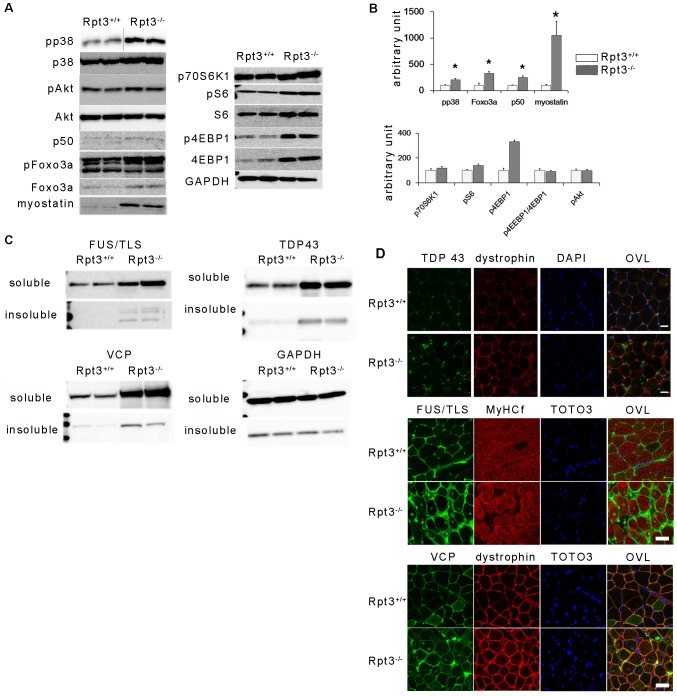
Catabolic pathways in the gastrocnemius muscles of Rpt3−/− mice. (A) Immunoblotting analysis for the detection of muscle atrophy-related signaling pathway components. (B) Quantification of the data from A. The amount of phosphorylated p38 (pp38) was also increased in Rpt3−/− mice. No apparent differences were observed in the levels of Akt and phosphorylated (p)Akt. Foxo3a, p50, and myostatin were increased. Phosphorylated (p)Foxo3a, p70S6K1, phosphorylated (p)S6, S6, phosphorylated (p)4EBP1, 4EBP1 and GAPDH were also present. The ratios of phosphorylated S6∶S6 and phosphorylated 4EBP1∶4EBP1 were not altered, whereas the total amount of phosphorylated 4EBP1 was increased. Data show the mean+s.e.m.; *P<0.05 (Student's t-test). (C) Proteins related to RNA metabolism accumulated in myofibers. Expression of the FUS/TLS, VCP and TDP-43 proteins was increased in Rpt3−/− mice, especially in the insoluble fractions. (D) Immunohistochemistry of TDP-43, FUS/TLS and VCP revealed that the amount of these markers localizing within myonuclei in Rpt3−/− mice was increased. TOTO3, nuclei; OVL, overlay. Scale bars: 20 µm (upper panel), 50 µm (middle and lower panels).